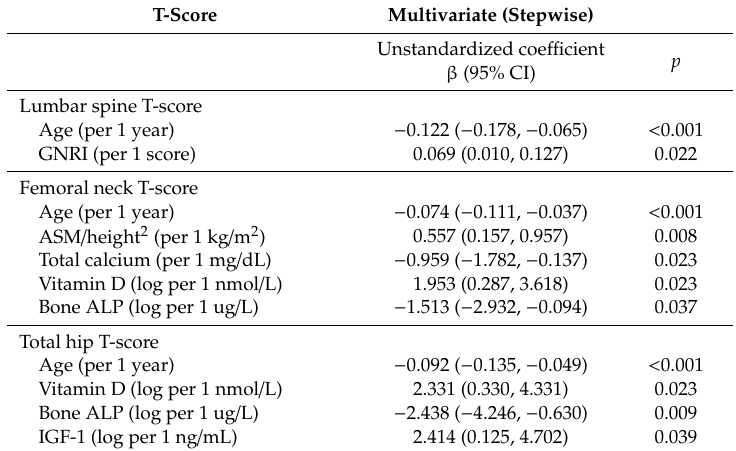
Table 3. Determinants of T-score using multivariable stepwise linear regression